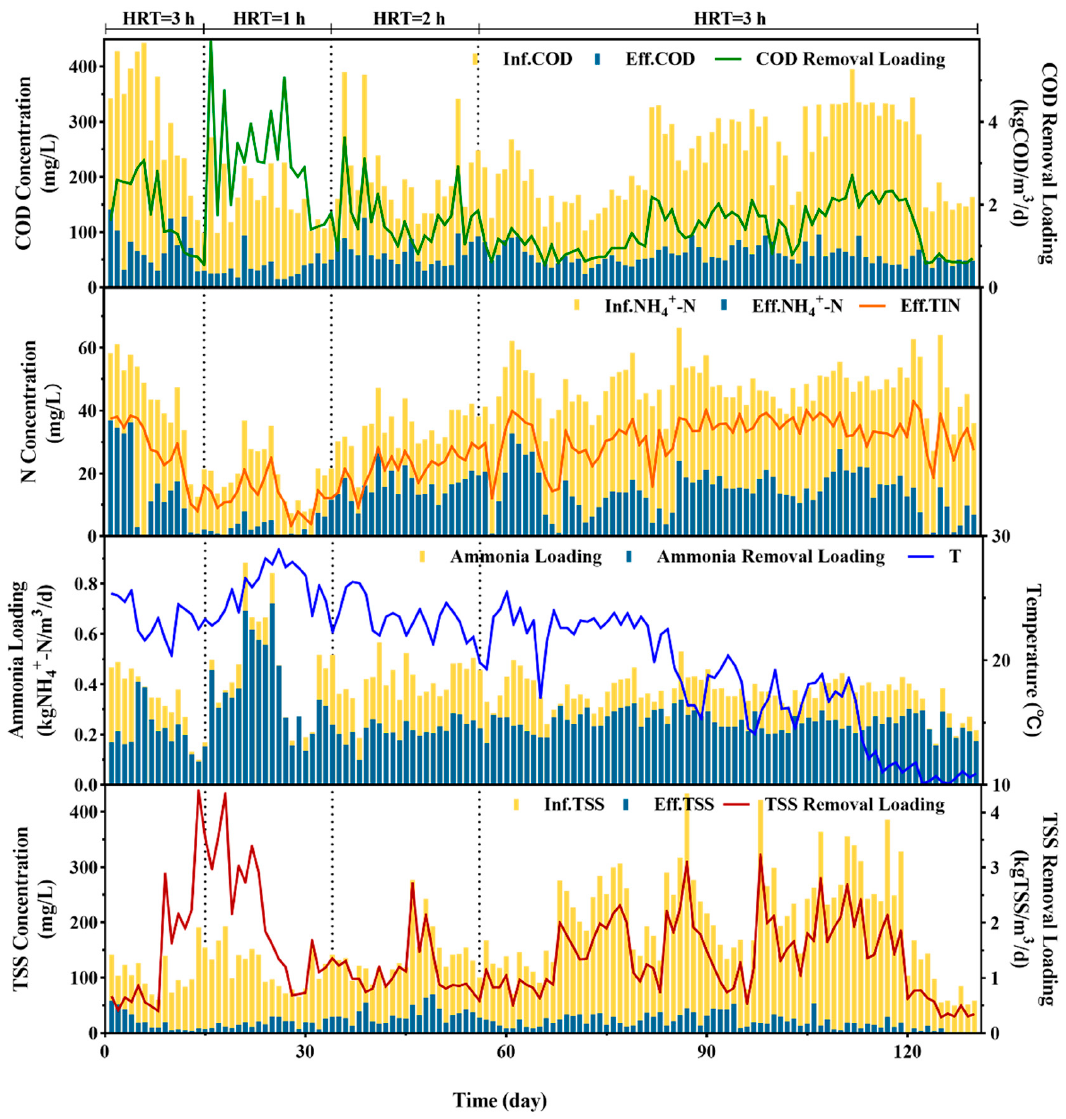
Figure 2. Nutrients removal performance in the bioreactor.